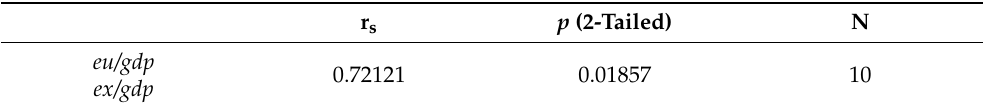
Table 12. Spearman’s Rho correlation coefficient between the ratios eu/gdp and ex/gdp for N = 10 with the countries with the lowest external